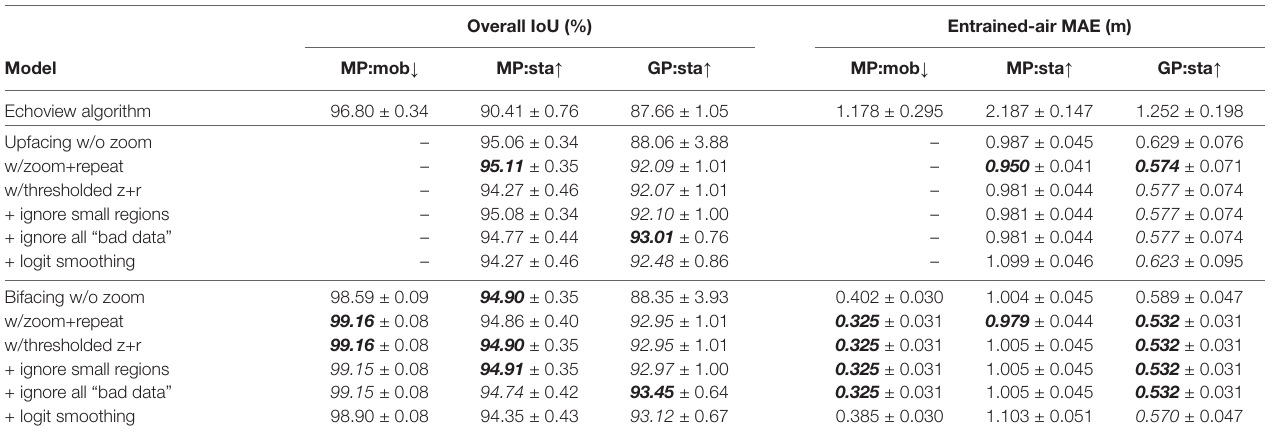
TABLE 3 | Impact of post-processing steps on the model performance